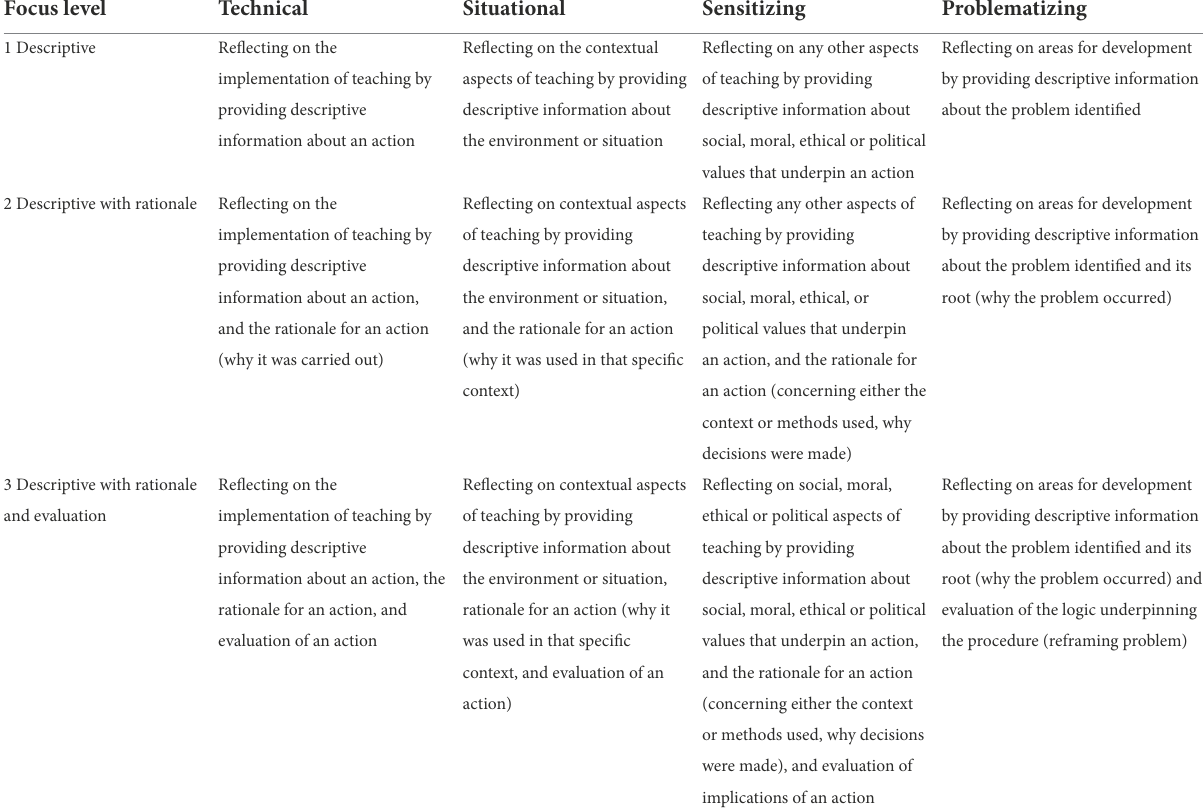
TABLE 2 A framework of reflection. Focus